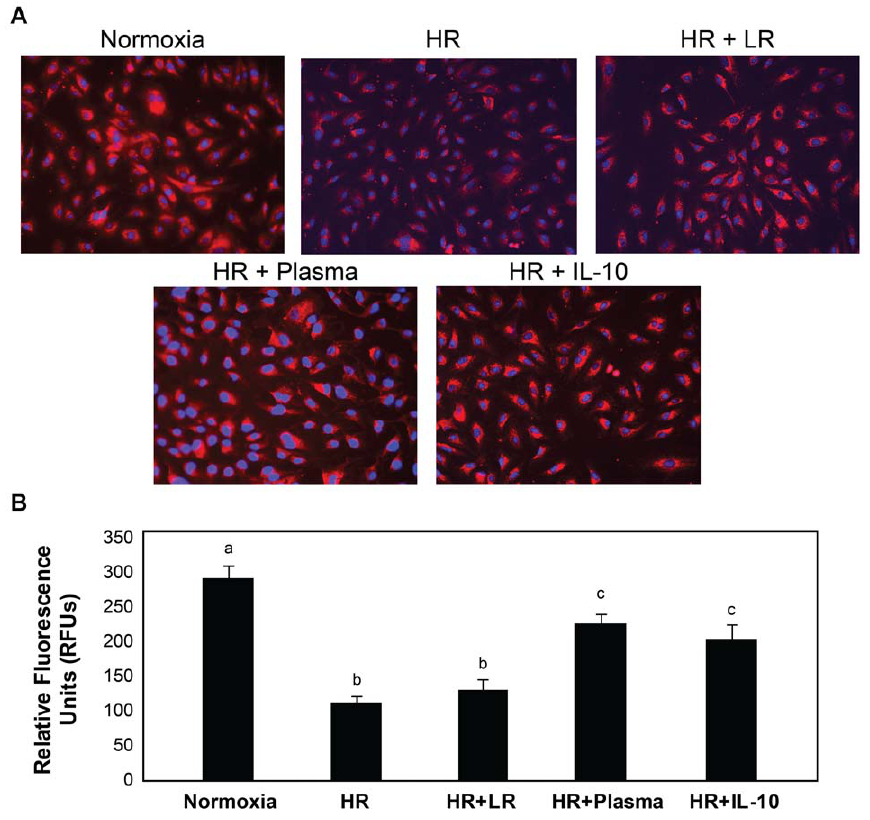
Figure 6. Cell surface syndecan-1 is enhanced by FFP in an in vitro model of endothelial injury. HUVEC’s were stimulated with IL-1 b and subjected to hypoxia for four hours followed by rexoygenation and incubation for an additional four hours in media alone (hypoxia/reoxygenation, HR), 5% lactated Ringers (LR) or5% FFP and compared to normoxia. A. Cell were labeled with antisyndecan-1 antibodies (magnification=ori- ginal 6 200) then B. Images obtained using an Olympus 1 6 71 microscope with SimplePCI6 software. Original image magnification, 6 20. The relative fluorescence intensity was quantified using Image J software (NIH) and reported as relative fluorescence units (RFU). Results are presented as means 6 SEM, n=6 images/group. Means notated with letters indicate statistical differences between groups. Immunostaining revealed that cell surface syndecan-1 is expressed abundantly in normoxia, significantly reduced after HR and LR, but partially restored by FFP.